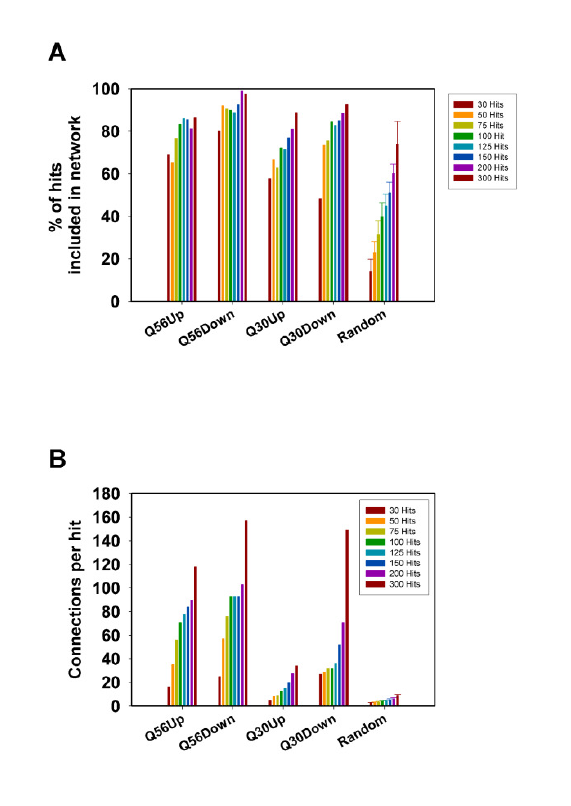
FIGURE 3: Analysis of network connectivity based on the number of initial hits. Connections between hits derived from the Q56- and Q30 datasets were calculated based on a variable number of hits. The top30-top300 most strongly regulated hits were used to construct a network. (A) Depicted are the number of hits, which are included in the interconnected network and (B) the average number of connections per hit. As a control 100 random sets of genes were used and processed in the same manner. The error bar represents the standard deviation for the 100 random gene